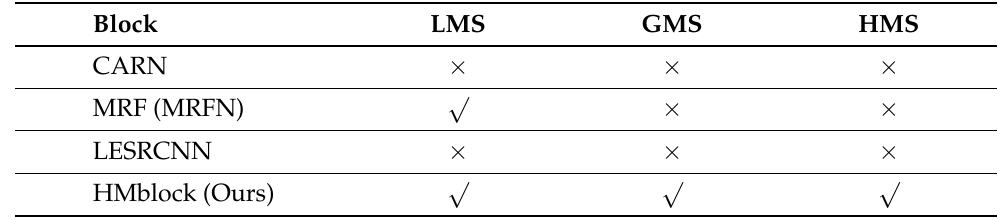
Table 3. Comparison of different image enhancement blocks: “LMS” means “local